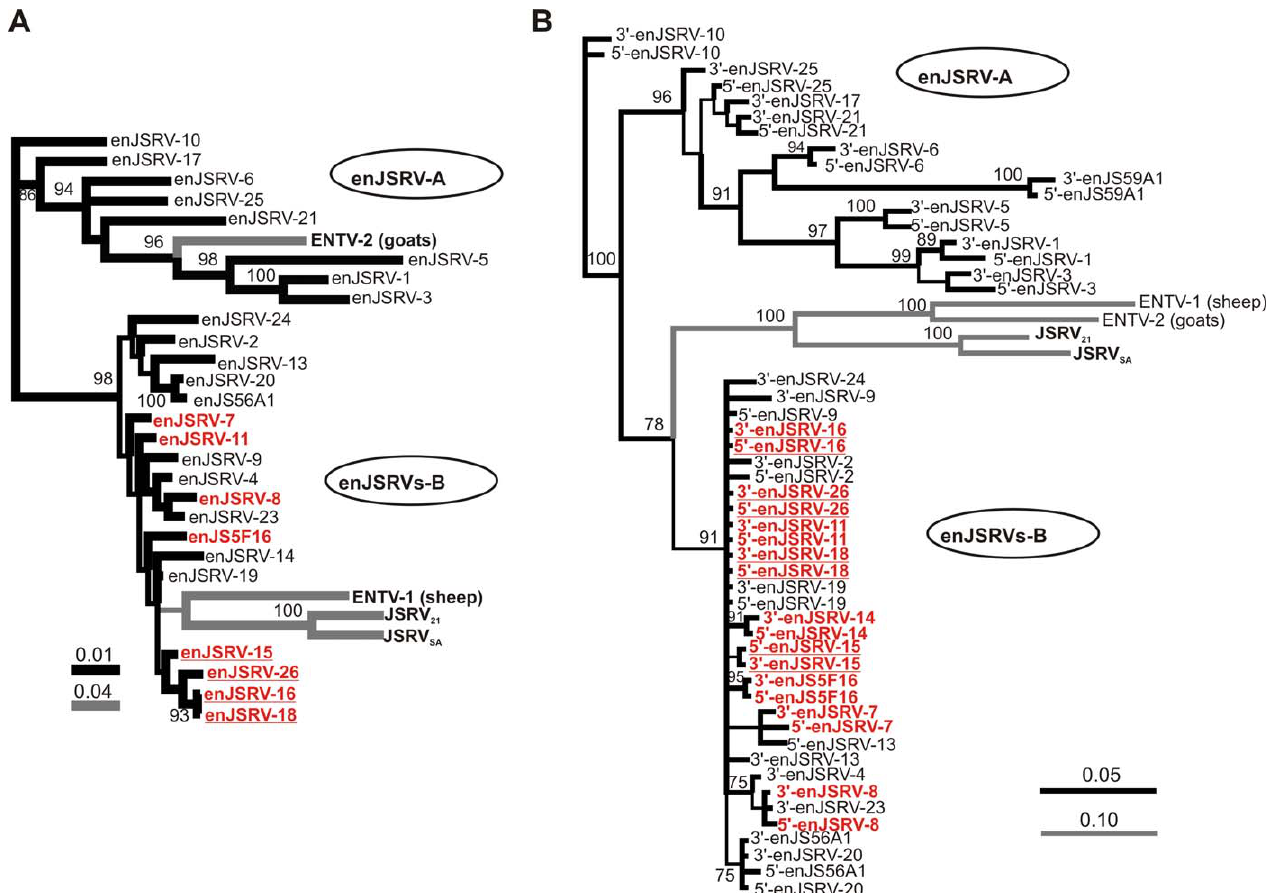
Figure 4. Phylogenetic Relationships among Endogenous and Exogenous Sheep Betaretroviruses (A) Phylogenetic tree based on the sequences of the full provirus (excluding LTRs). (B) Phylogenetic tree based only on LTR sequences. Genealogies shown represent Bayesian 50% majority rule consensus trees and were rooted using isolate enJSRV-10, which is shared among Ovis and Capra spp. Clades with posterior probability values at least 0.95 are indicated by thick branches. Bootstrap scores 70% or above from ML analysis (based on 200 replicates) are shown above branches. For the larger LTR dataset, 1,000 replicates were analyzed using the neighbor-joining method with distances calculated from the ML model. Branches in grey are shown at smaller scales, which allowed for easier graphical representation of both fast-evolving exogenous and slow-evolving endogenous forms in the same tree figure. Two well-supported clades are visible in both trees. Provirus names in red indicate the insertionally polymorphic loci, while those underlined are the enJSRVs that show an intact genomic organization with complete uninterrupted open reading